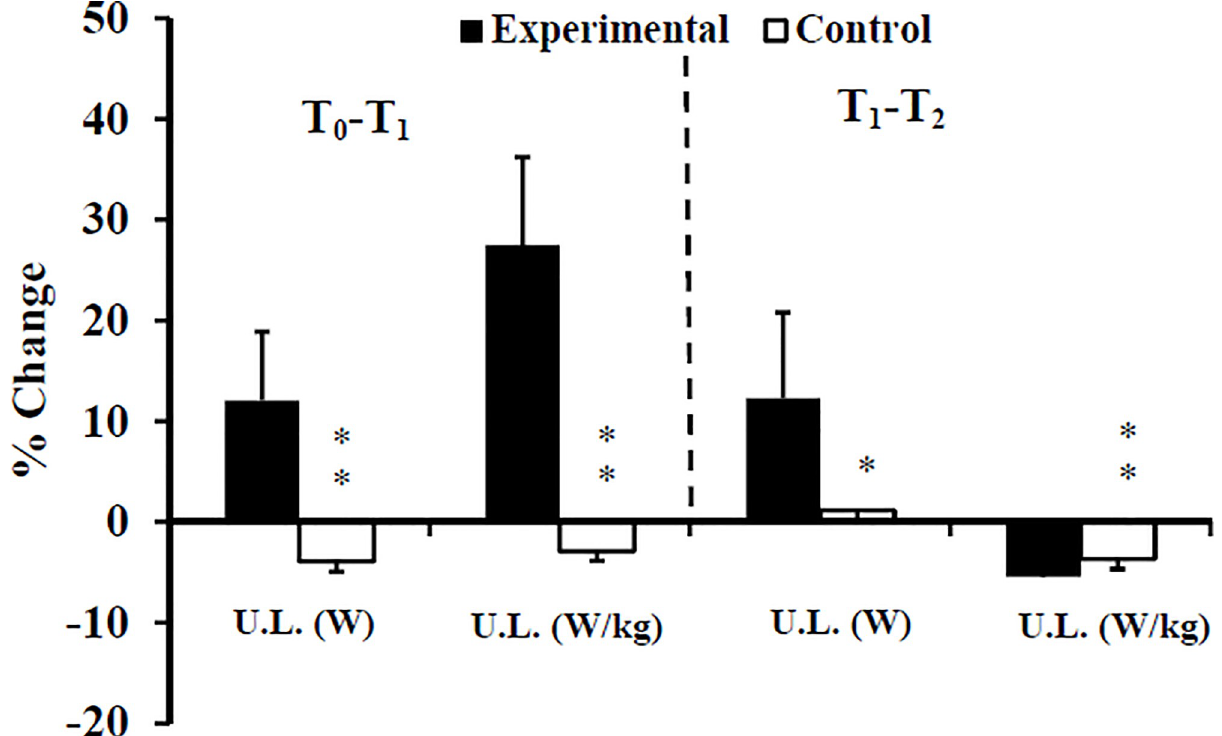
Fig 3. Percentage changes of power of upper limb at T 1 , and T 2 for Experimental (E) and Control (C) groups. T 0 : before training; T 1 : after 10 weeks of resistance training; T 2 : after 2 weeks of tapering; U.L: upper limb; � : ANOVA group x time interaction significantly different between E and C at the level of p < 0.05; �� : ANOVA group x time interaction significantly different between E and C at the level of p < 0.01.